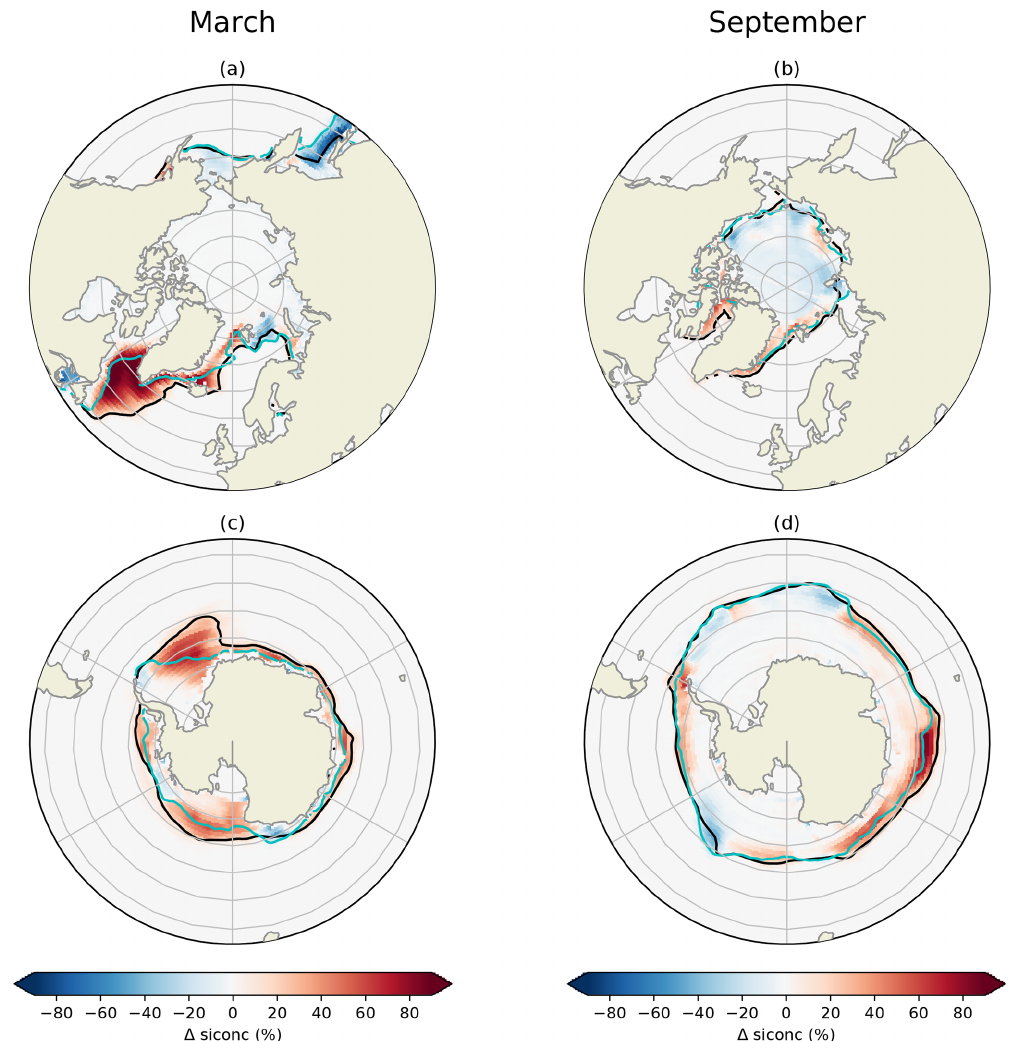
Figure 20. Sea-ice concentration biases between CanESM5 and NSIDC climatologies for the months of March (a, c) and September (b, d) in the Northern Hemisphere (a, b) and Southern Hemisphere (c, d) . The solid black contour marks the ice edge (15% threshold) in CanESM5, and the teal line marks the ice edge in the observations. Biases are based on the 1981 to 2010